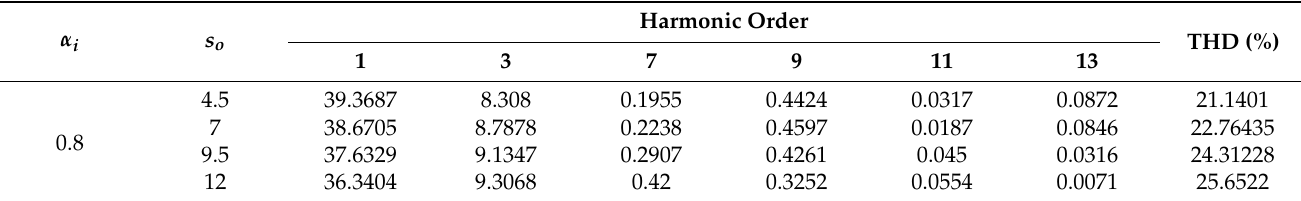
Figure 8. Proposed optimization of rotor pole. ( a ) Pole width to pole pitch ratio ( α i ), ( b ) stator slot opening width ( s o ). Table 2. Harmonic magnitude of the combination between α i and s o .